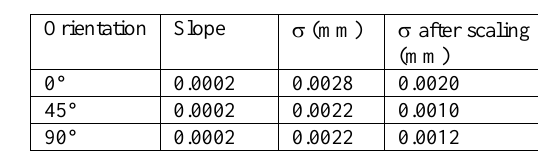
Figure 7: Deviation between unidirectional lengths for holeplate at 1.6 times magnification in three orientations (using same y axis scale as bidirectional graphs) Figure 4: Differences between unidirectional and bidirectional measurements The scale factor can be determined by using the gradient of the trend in the data, the slope along with the standard deviation of the data can be seen in Figure 8.